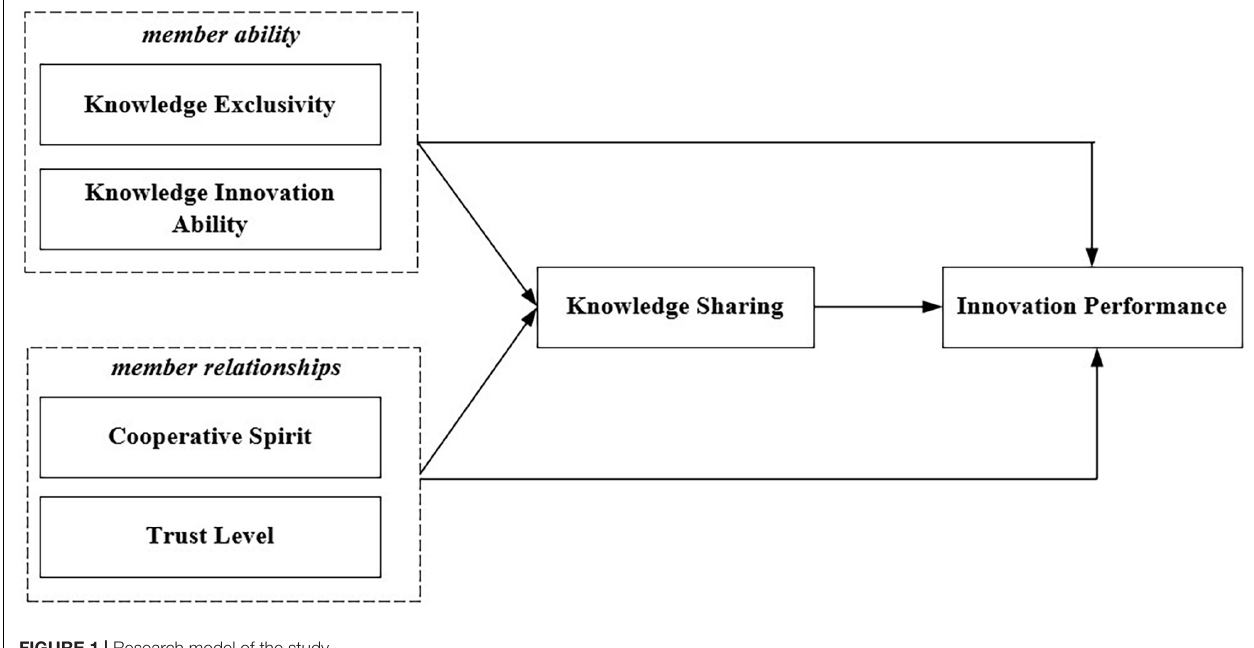
FIGURE 1 | Research model of the